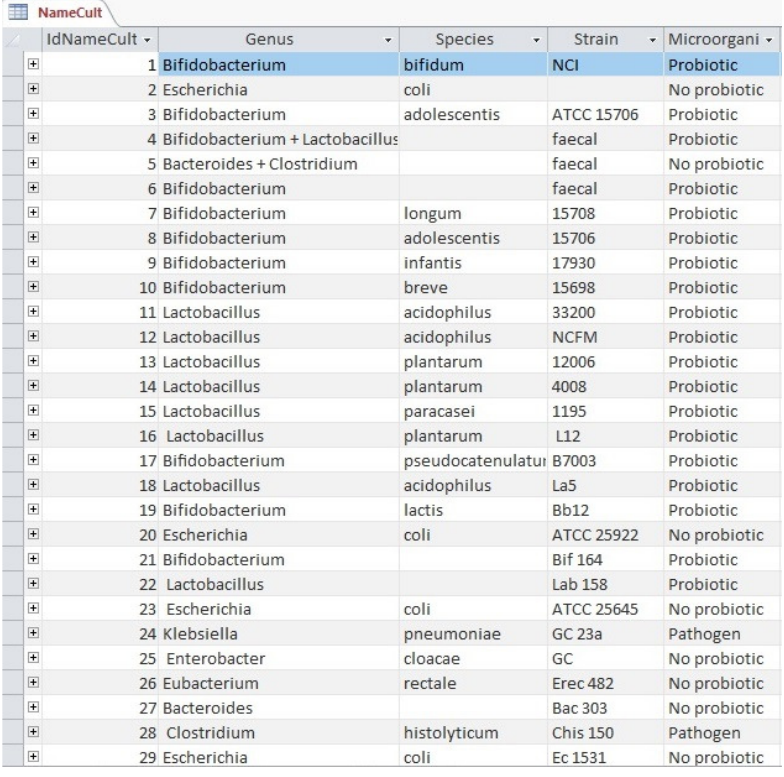
Figure 4. Table «NameCult» containing the information about various types of